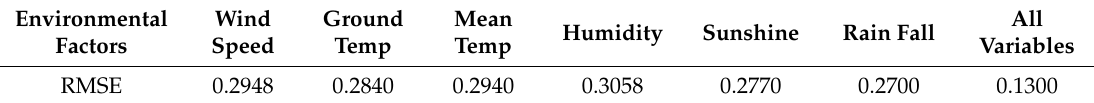
Table 6. RMSE for six environmental factors and all